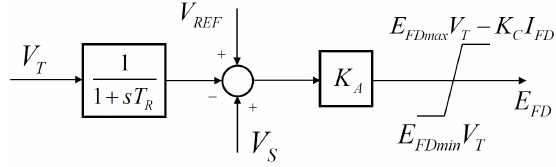
Figure A1. Excitation